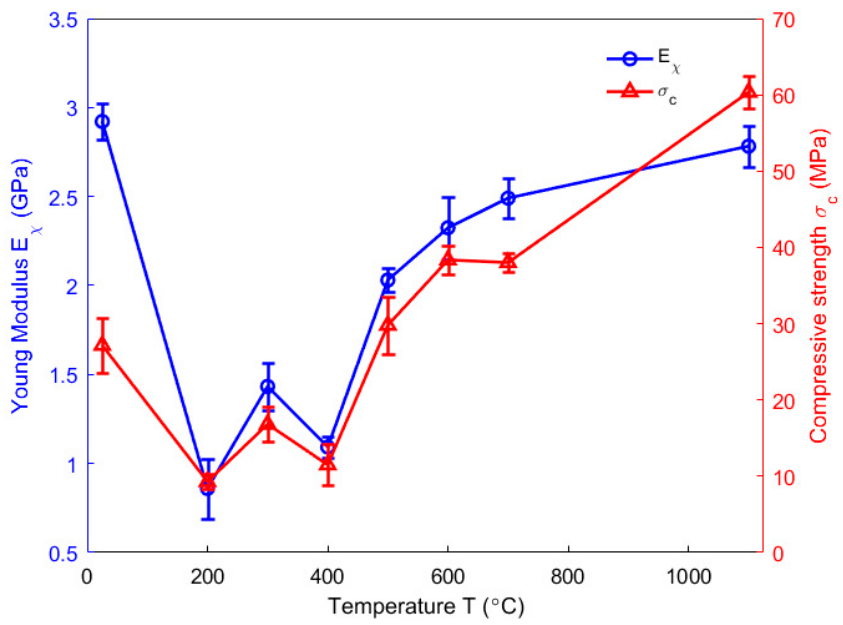
Figure 16. Evolution of Young Modulus and compressive strength as a function of temperature [37].